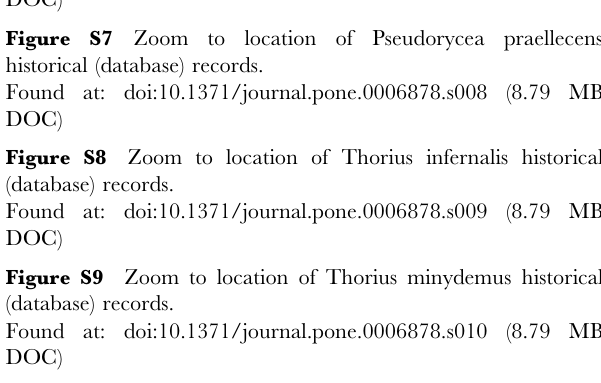
Figure S2 Zoom to location of Craugastor uno historical (database) records. Found at: doi:10.1371/journal.pone.0006878.s003 (8.79 MB Figure S3 Zoom to location of Lithobates psilonota historical (database) records. Found at: doi:10.1371/journal.pone.0006878.s004 (8.79 MB Figure S4 Zoom to location of Lithobates publeae historical (database) records. Found at: doi:10.1371/journal.pone.0006878.s005 (8.79 MB Figure S5 Zoom to location of Plectrohyla labedactyla historical (database) records. Found at: doi:10.1371/journal.pone.0006878.s006 (8.79 MB Figure S6 Zoom to location of Plectrohyla pachyderma historical (database) records. Found at: doi:10.1371/journal.pone.0006878.s007 (8.79 MB Figure S7 Zoom to location of Pseudorycea praellecens historical (database) records. Found at: doi:10.1371/journal.pone.0006878.s008 (8.79 MB Figure S8 Zoom to location of Thorius infernalis historical (database) records. Found at: doi:10.1371/journal.pone.0006878.s009 (8.79 MB Figure S9 Zoom to location of Thorius minydemus historical (database) records. Found at: doi:10.1371/journal.pone.0006878.s010 (8.79